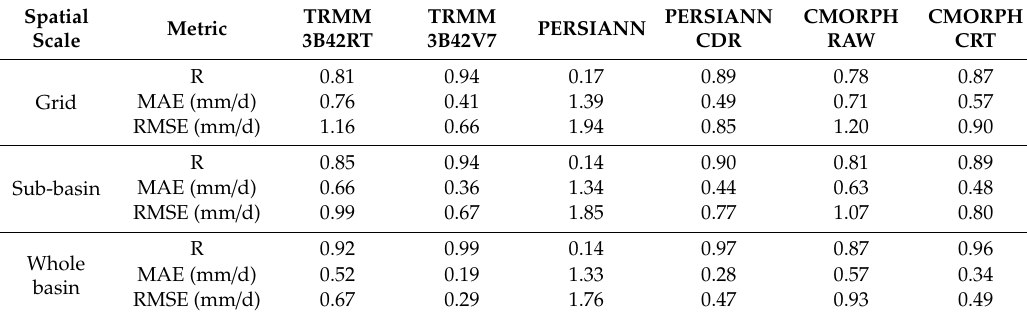
Table 3. SPP evaluation results at a monthly scale with di ff erent spatial scales.